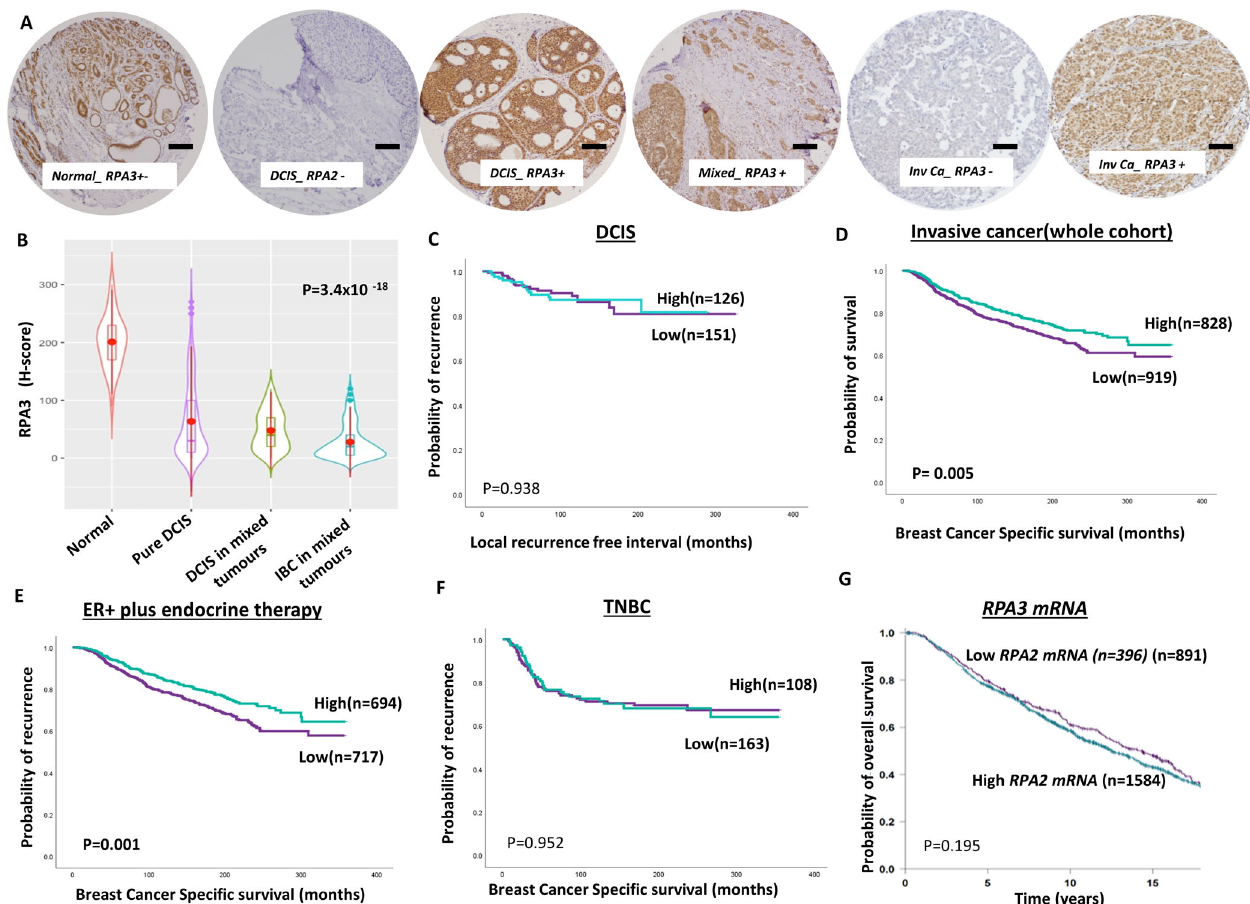
Fig. 3 Clinicopathological studies of RPA3 expression in breast cancers. A Photomicrographs showing immunohistochemical staining of RPA3 in breast cancers (scale bar “ − “ = 100 µM). B Violin plot shows the mean of RPA3 expression in normal, pure DCIS and DCIS mixed tumours [The red dot represents the median, open red bar in the center represents the interquartile range, the thin red line represents the rest of the distribution, except for points that are “ outliers ” . On each side of the red line is a kernel density estimation to show the distribution shape of the data. Wider sections of the violin plot represent a higher probability that members of the population will take on the given value; the skinnier sections represent a lower probability.]. C Kaplan – Meier curve for RPA3 nuclear protein expression and recurrence-free interval (LRFI) in DCIS ( D ) a Kaplan – Meier curve for RPA3 nuclear protein expression and breast cancer-speci fi c survival (BCSS) in the whole cohort. E Kaplan – Meier curve for RPA3 nuclear protein expression and BCSS in ER + cohort with endocrine therapy. F Kaplan – Meier curve for RPA3 nuclear protein expression and BCSS in triple negative (TN) in the whole cohort. G Kaplan – Meier curve for RPA3 mRNA expression and breast cancer-speci fi c survival (BCSS) in the whole cohort. Survival rates were determined using Kaplan – Meier method and compared by the log- rank test. All analyses were conducted using Statistical Package for the Social Sciences (SPSS, version 22, Chicago, IL, USA) software for windows. P value of less than 0.05 was identi fi ed as statistically signi fi